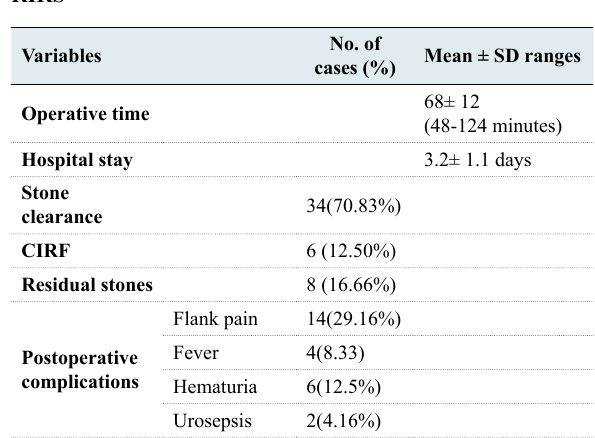
Table 2: Perioperative outcomes of the pateient